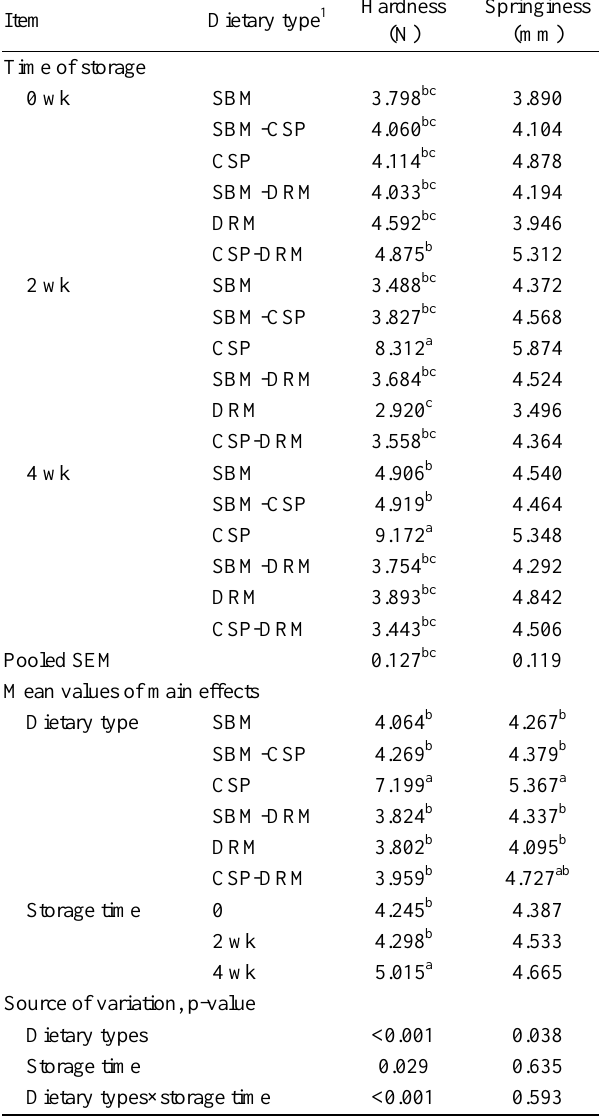
Table 4. Effect of dietary types and storage time on hardness and springiness of cooked